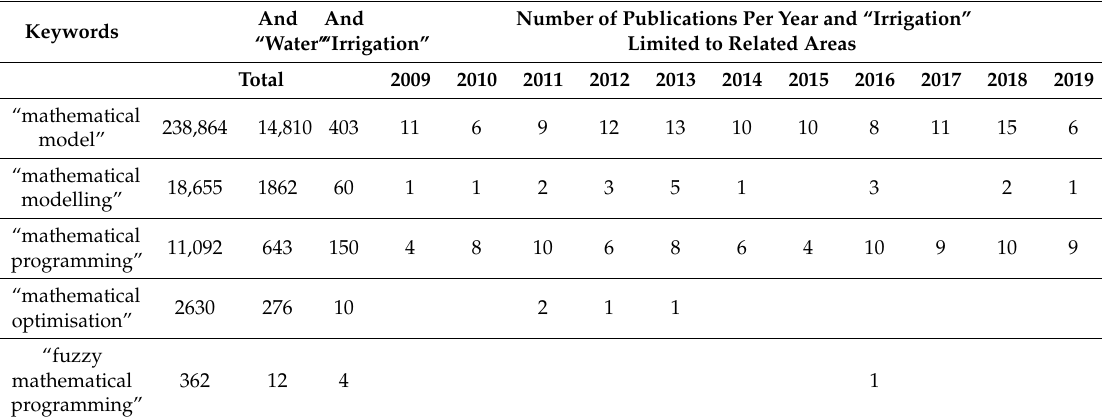
Table 1. Number of publications according to the di ff erent searches performed in the literature